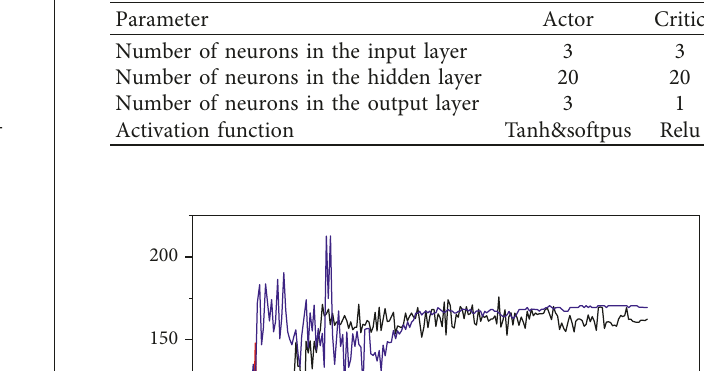
Table 1: Settings of neural network parameter.